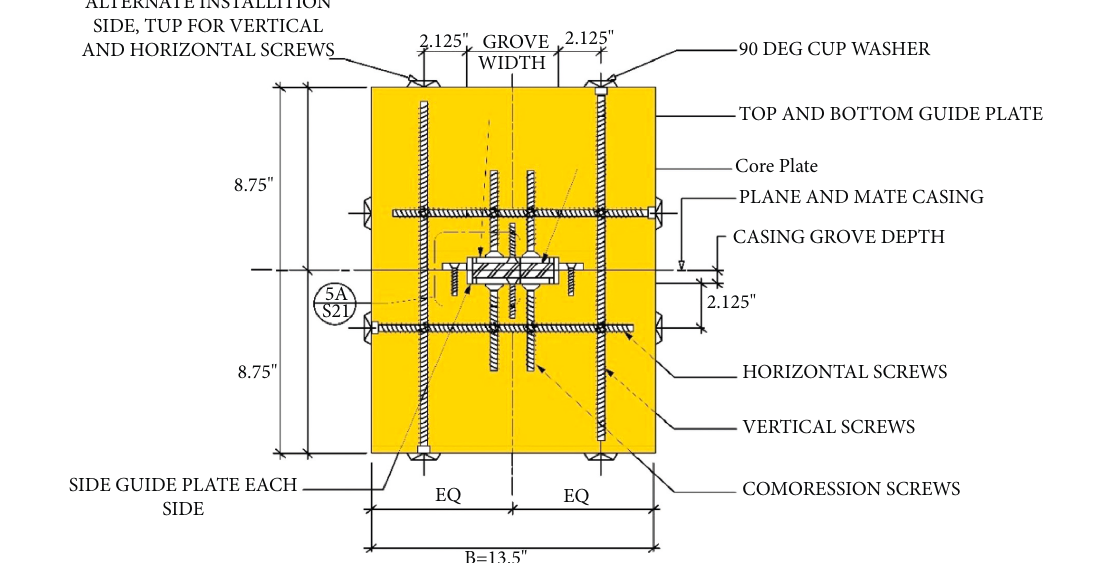
Figure 1: TS-BRB section details.